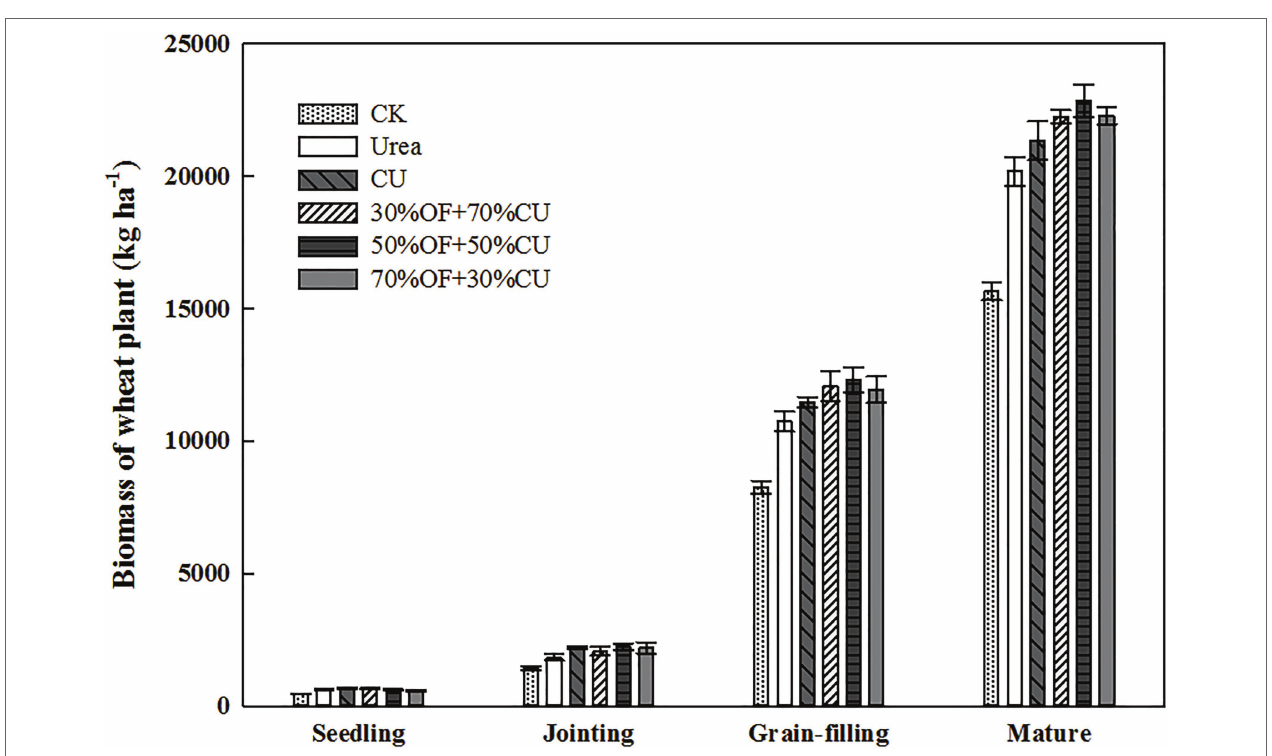
FIGURE 3 | Biomass dynamics of wheat plants during the growing